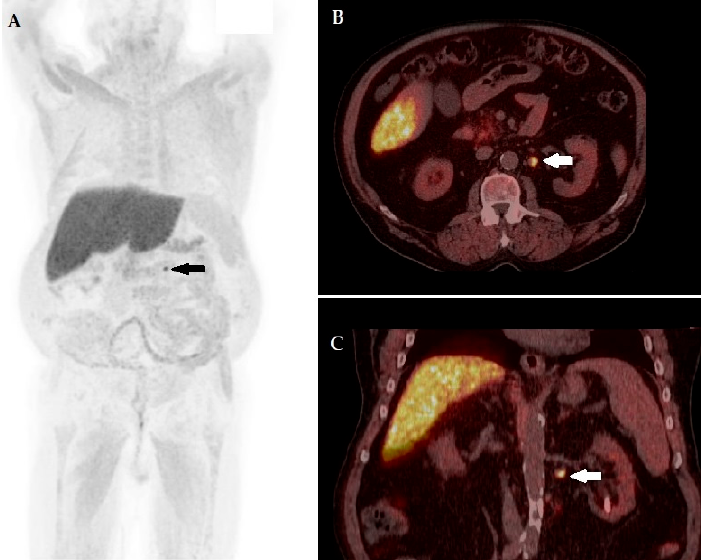
Figure 7. A 74-year-old patient 5 years post radiotherapy for cT2b ISUP Grade Group 4 prostate adenocarcinoma, presenting biochemical recurrence with PSA level prior to PET/CT of 1.25 ng/mL. ( A ) MIP image showing an area of increased tracer incorporation in the left umbilical region (arrow). Fused corresponding PET/CT axial ( B , arrow) and coronal ( C , arrow) slices depicting a round-shaped para-aortic lymph node, located below the left kidney artery, characterized by 18 F-FACBC pathological uptake, with a maximum diameter of 14 mm and a maximum standard- ized uptake value (SUV max ) of 10.1, superior to bone marrow SUV mean (3.3). Final diagnosis was T0N0M1a according to PROMISE. Intended therapy prior to PET/CT was androgen deprivation therapy, after the collegial discussion of 18 F-FACBC PET/CT’s results, the patient was submitted to stereotactic radiotherapy on the abdominal node with PSA response.